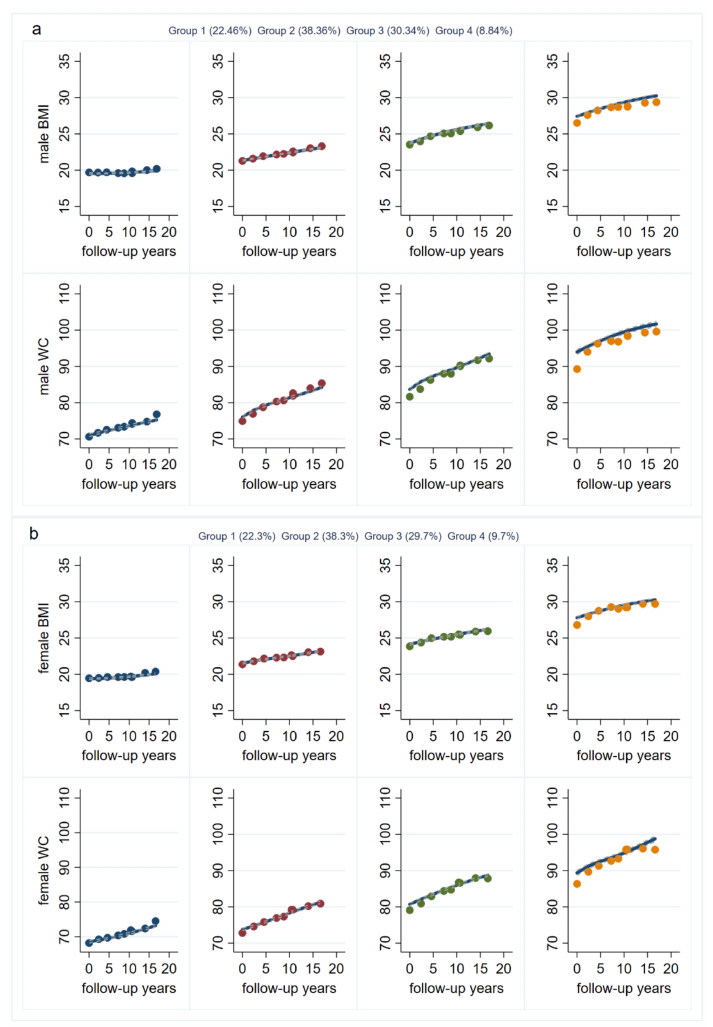
Figure 2. Trajectories of BMI and WC among males ( a ) and females ( b